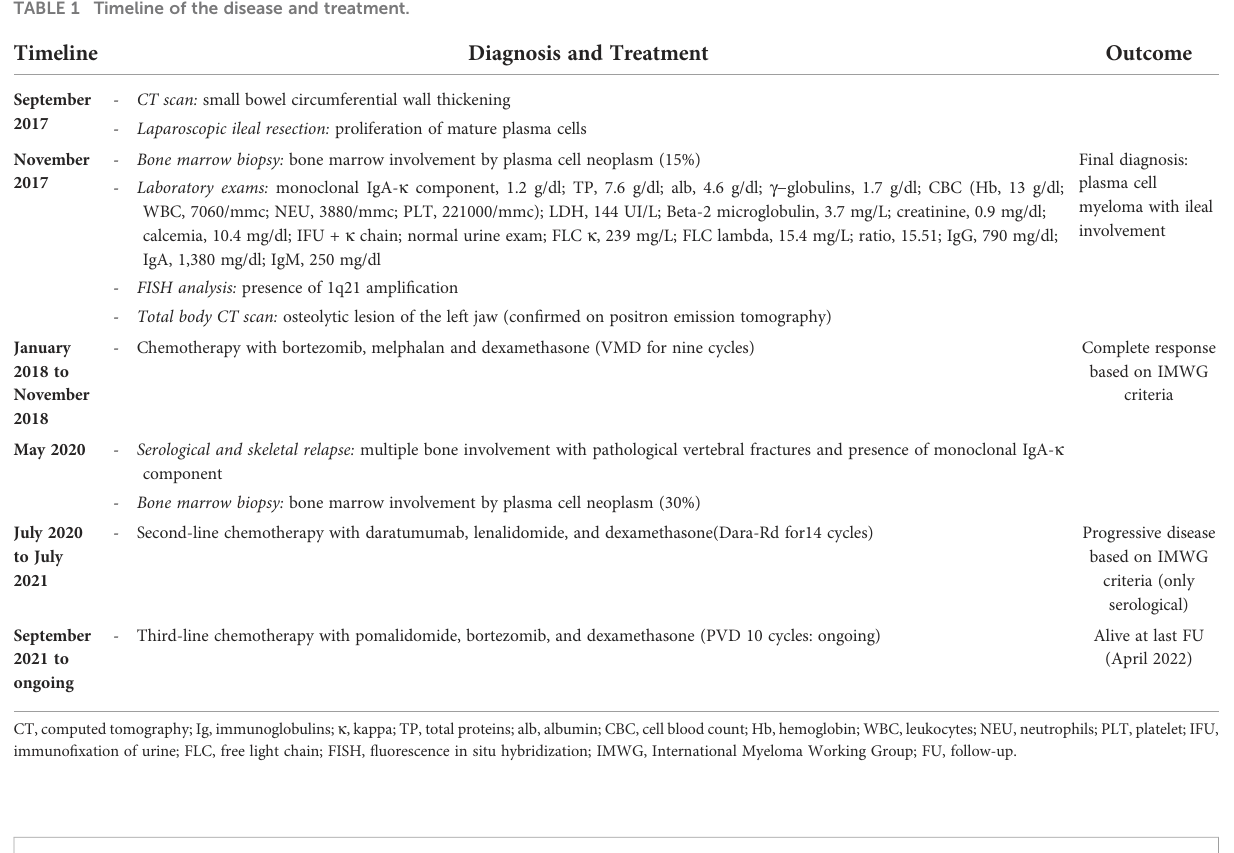
TABLE 1 Timeline of the disease and treatment.